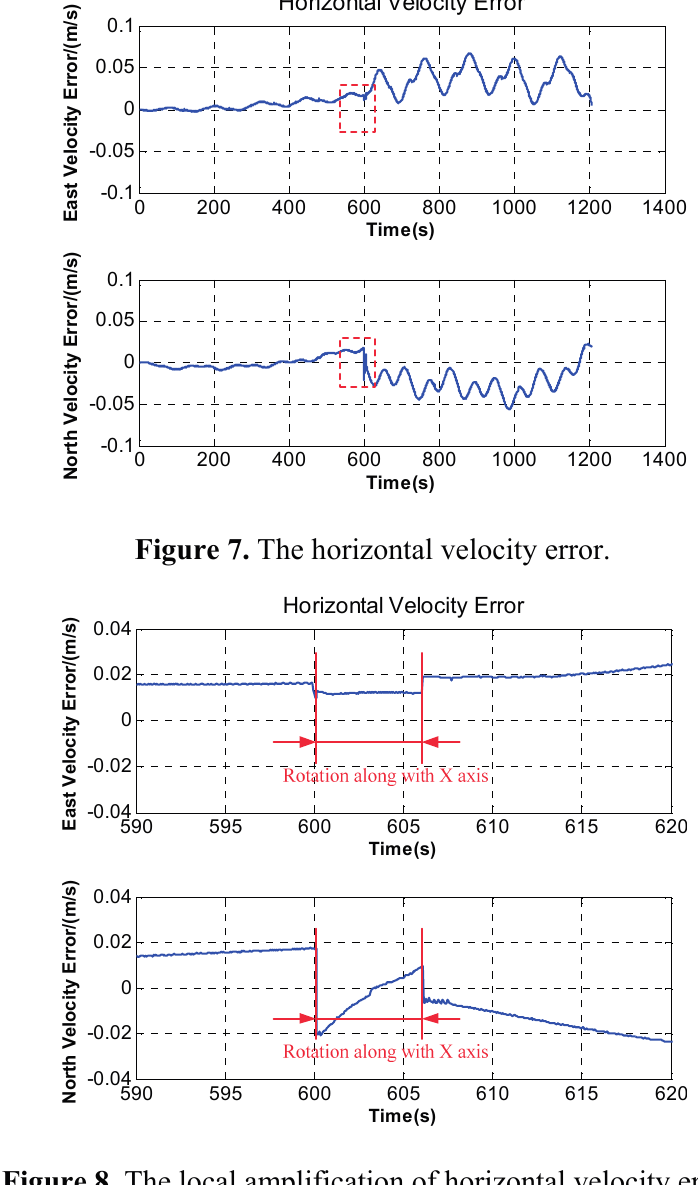
Figure 8. The local amplification of horizontal velocity